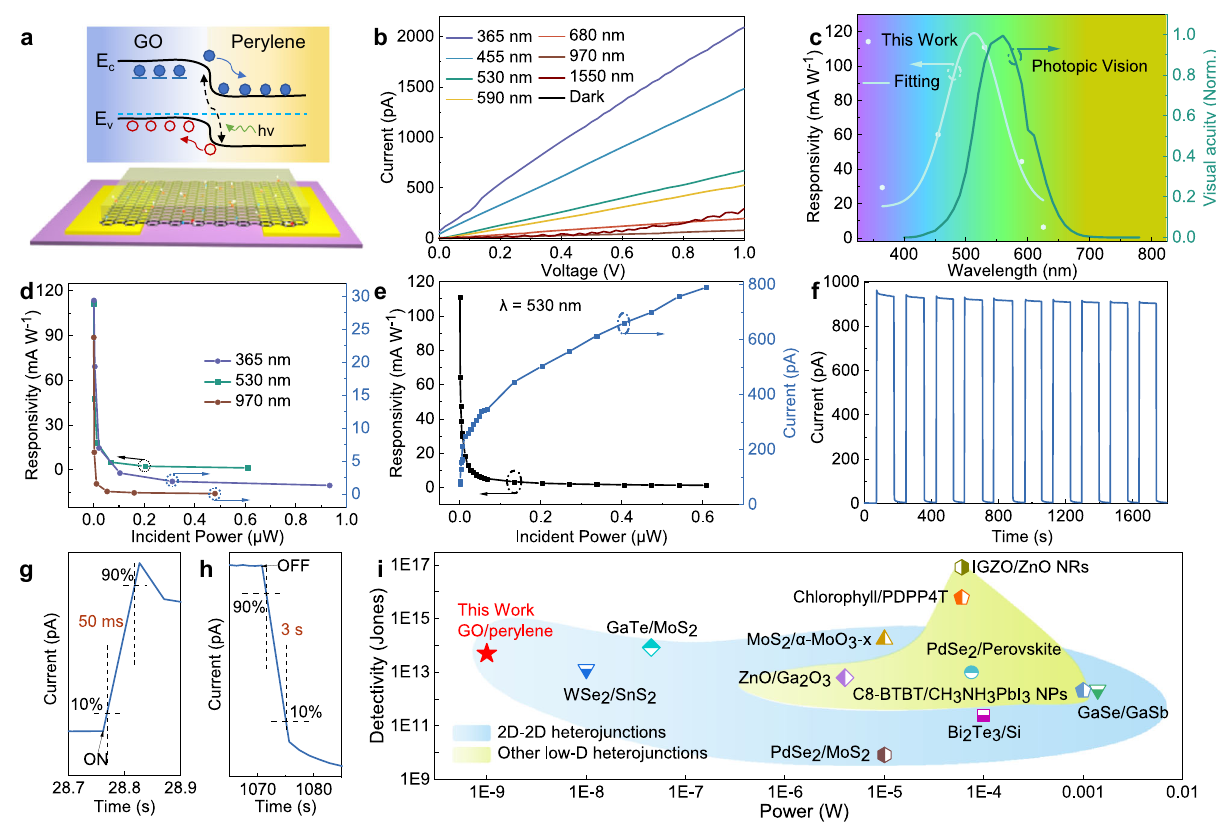
Fig. 3 | Perylene/GO heterobilayer photodetector. a Structural scheme and energy band diagram of the in-plane heterostructure device. b Photoresponse behaviors under UV, visible and NIR light stimuli. c Visual sensitivity of the human eye and visible light responsiveness of the detector. d Photoresponsivity as a function of incident light power at 365, 530, and